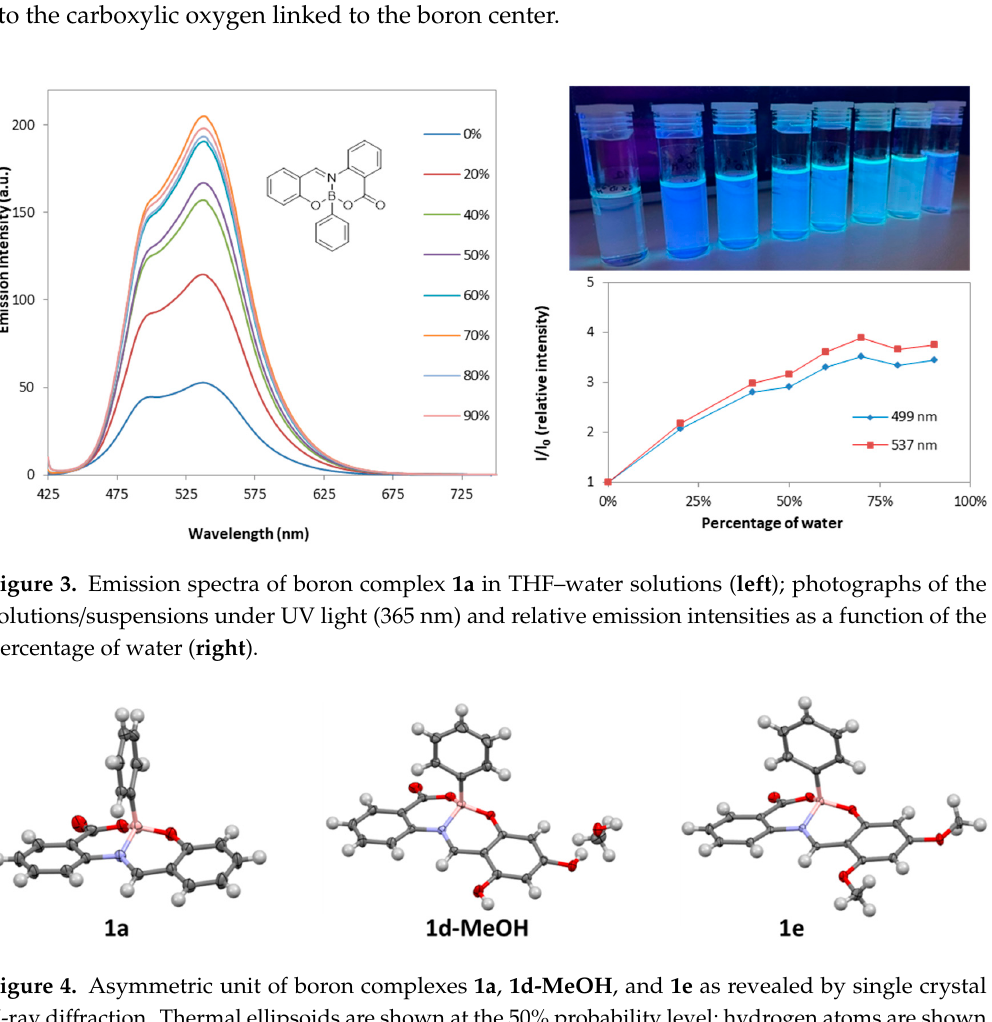
Figure 4. Asymmetric unit of boron complexes 1a , 1d-MeOH , and 1e as revealed by single crystal X-ray diffraction. Thermal ellipsoids are shown at the 50% probability level; hydrogen atoms are shown with an arbitrary radius (0.30 Å). C, grey; N, blue; O, red; B, pink; H, white.